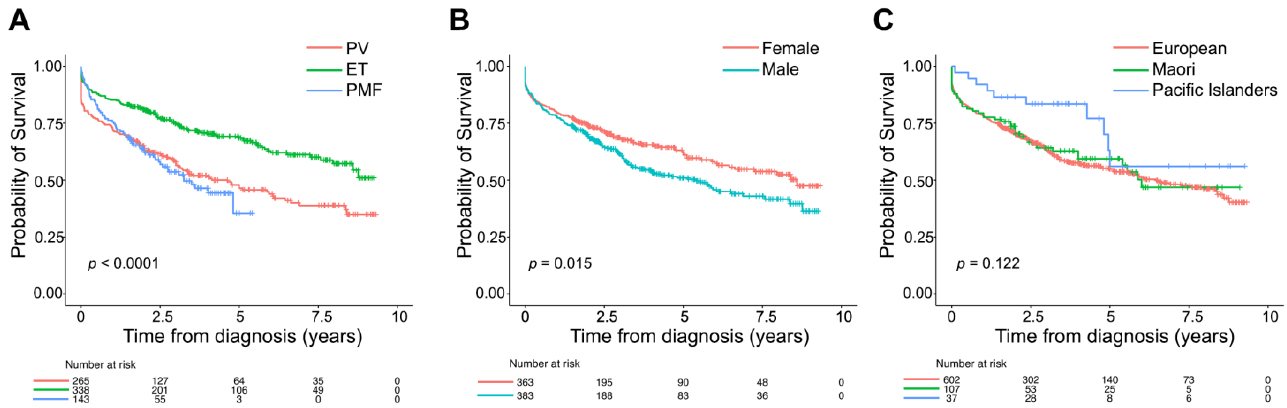
Figure 2. Survival of patients with Ph-negative myeloproliferative neoplasm reported to the New Zealand Cancer Registry between 2010 and 2017. Kaplan–Meier survival curves comparing cumulative survival probability of the entire cohort of myeloproliferative neoplasms patients stratified by diagnosis ( A ), gender ( B ), and main ethnic groups ( C ). Log-rank p values are shown. PV, polycythaemia vera; ET, essential thrombocythaemia; PMF, primary myelofibrosis. Table 2. Cox-regression model of predictors of mortality in MPN patients captured by the New Zealand Cancer Registry during